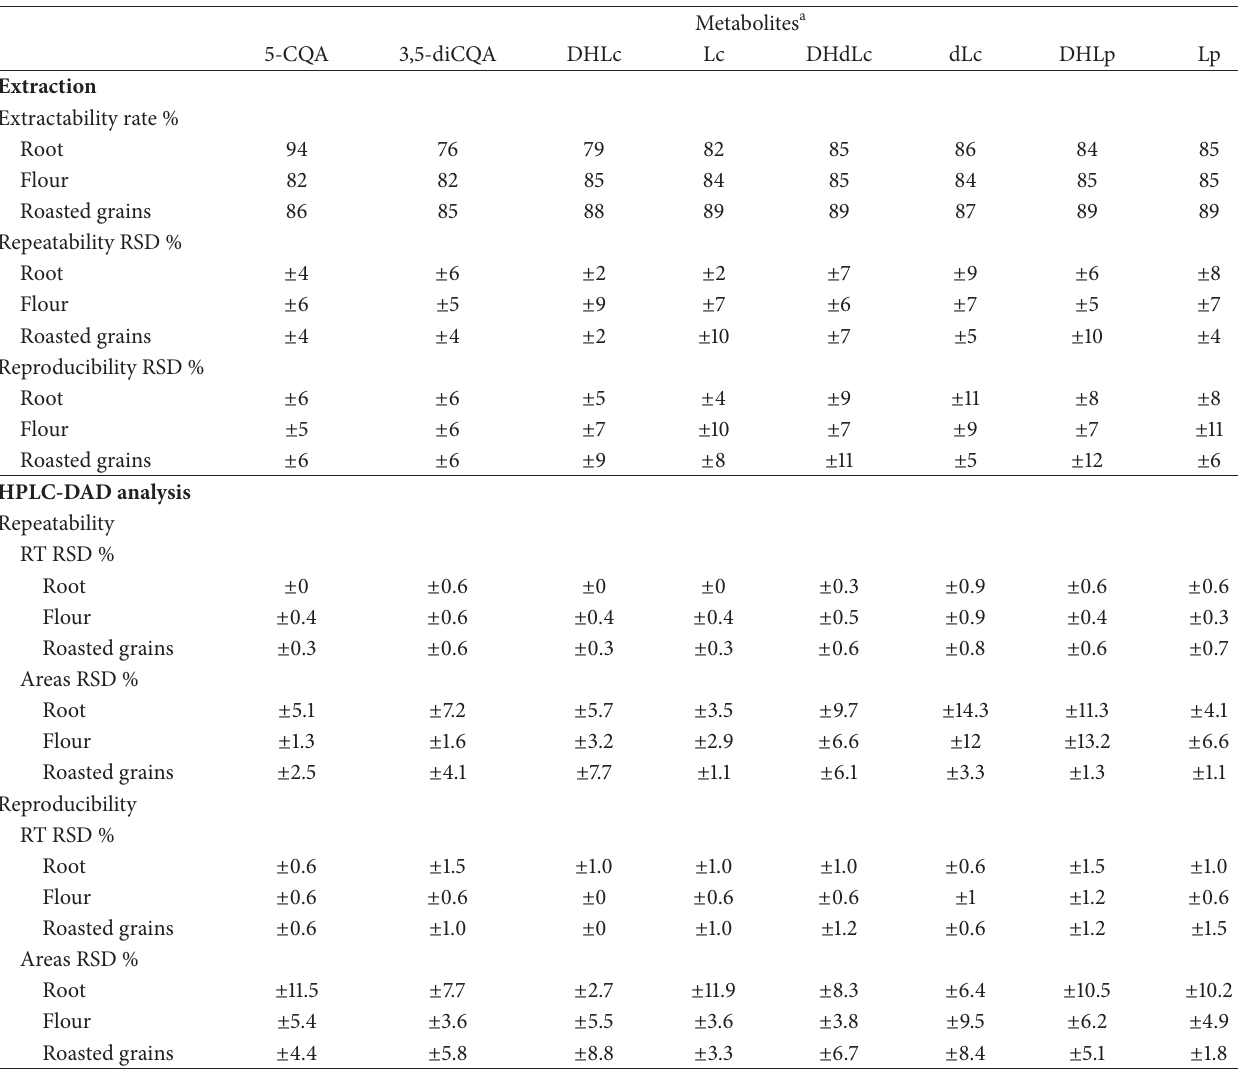
Table 4: Extractability rate of the extraction H the variation (RSD %) of contents. The repeatability and reproducibility of the HPLC-DAD method are expressed in terms of the variation (RSD %) of retention times (RT) and